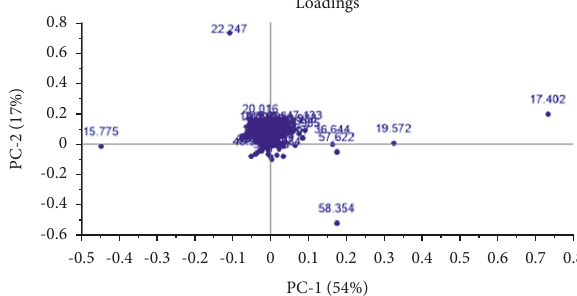
-0.5 -0.4 -0.3 -0.2 -0.1 Figure 10: PCA Loading plot of 47 batches of Acacia catechu .